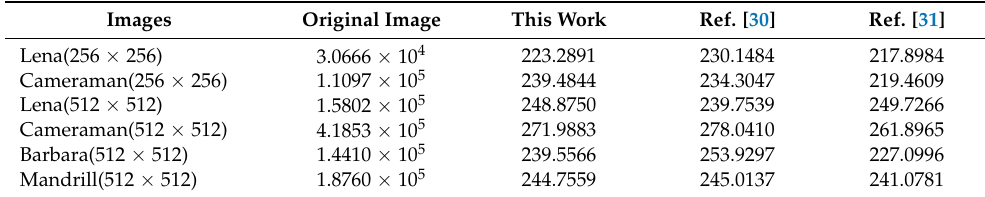
Table 3. χ 2 values of images encrypted by different